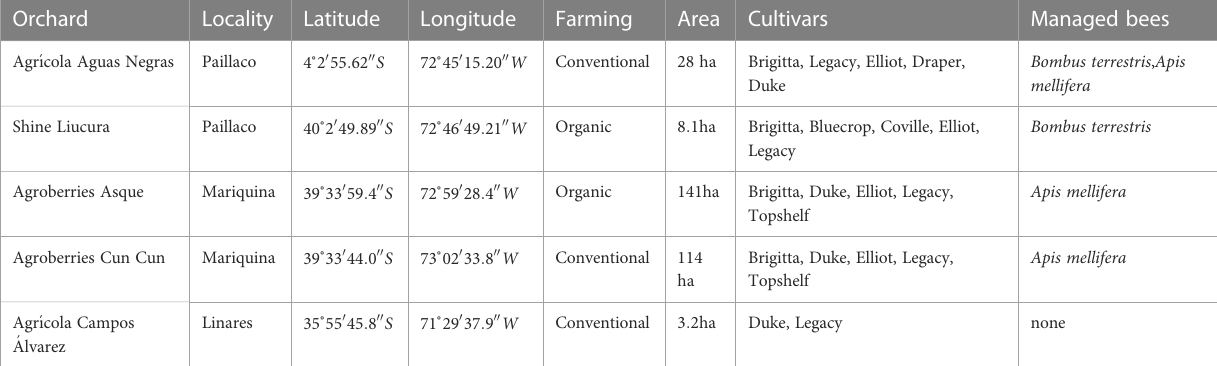
TABLE 1 Information for the studied highbush blueberry orchards where bee buzzing sounds were acquired between the months of September and November in 2020 and 2021.